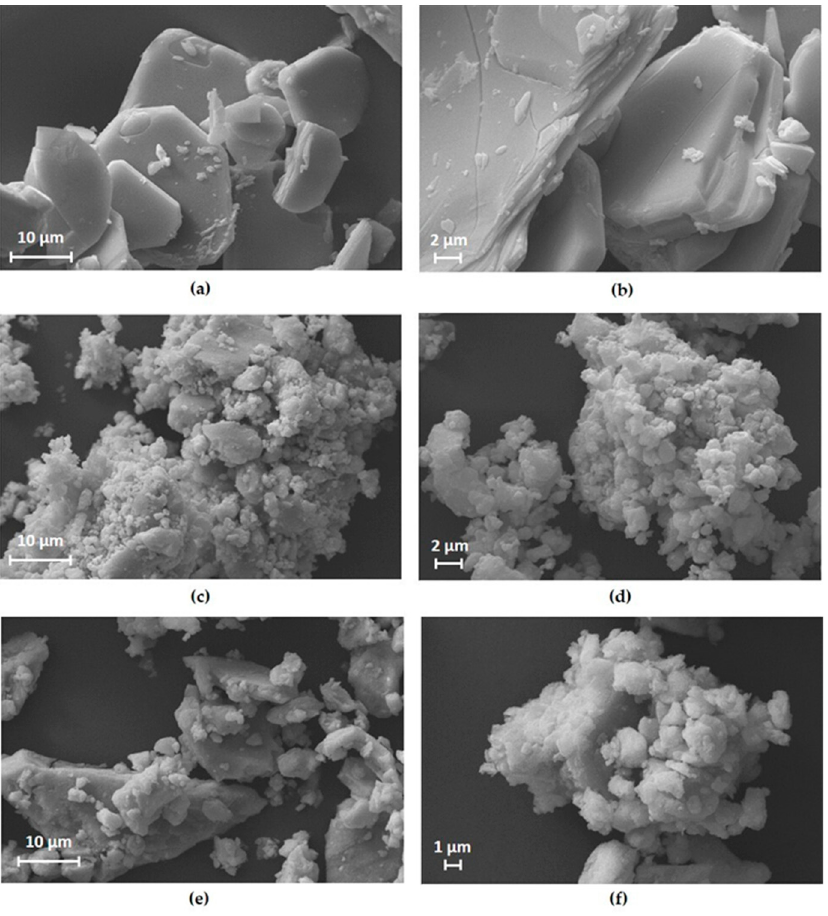
Figure 4. SEM images, at 5 k × and 10 k × magnification, of ( a , b ) as-prepared PEA 2 PbI 4 , and that after ( c , d ) 204 and ( e , f ) 420 h of ball-milling.